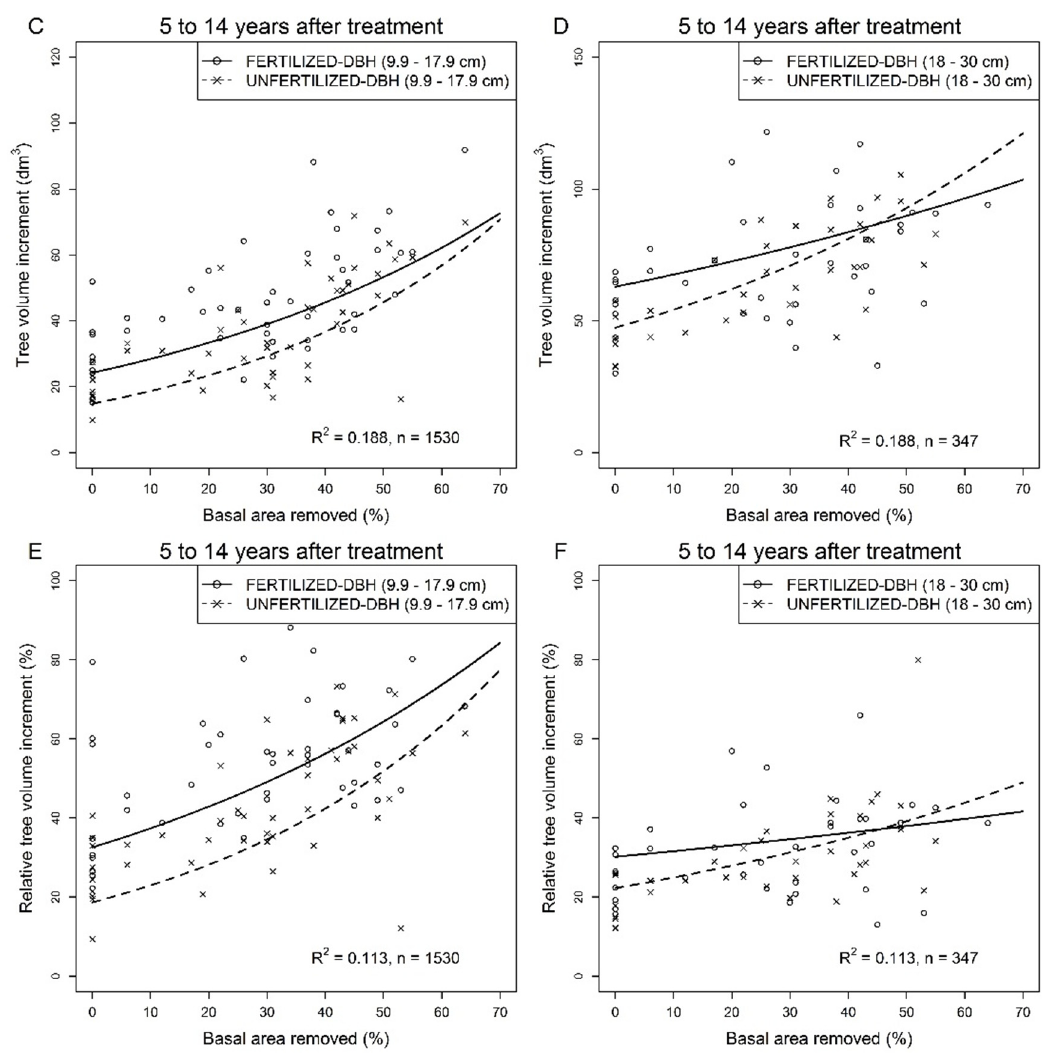
Figure 3. Response of residual trees in jack pine stands after commercial thinning and fertilization over periods of 5 to 14 following thinning. ( A ) Relative tree volume increment over the first 5 years after commercial thinning in unfertilized plots; ( B ) Mean tree volume in fertilized and unfertilized plots 14 years after commercial thinning; ( C ) Fertilized and unfertilized small diameter tree volume increment over the 5- to 14-year period following commercial thinning; ( D ) Fertilized and unfertilized large diameter tree volume increment over the 5- to 14-year period following commercial thinning; ( E ) Relative tree volume increment of fertilized and unfertilized small diameter trees over the 5- to 14-year period following commercial thinning; ( F ) Relative tree volume increment of fertilized and unfertilized large diameter trees over the 5- to 14-year period following commercial thinning. Untransformed observed (dots) and predicted (lines) values. Predicted values for tree volume increment were back-transformed from a log transformation and corrected according to Sprugel [52]. For all figures, individual tree values were averaged over sampling plots for illustration